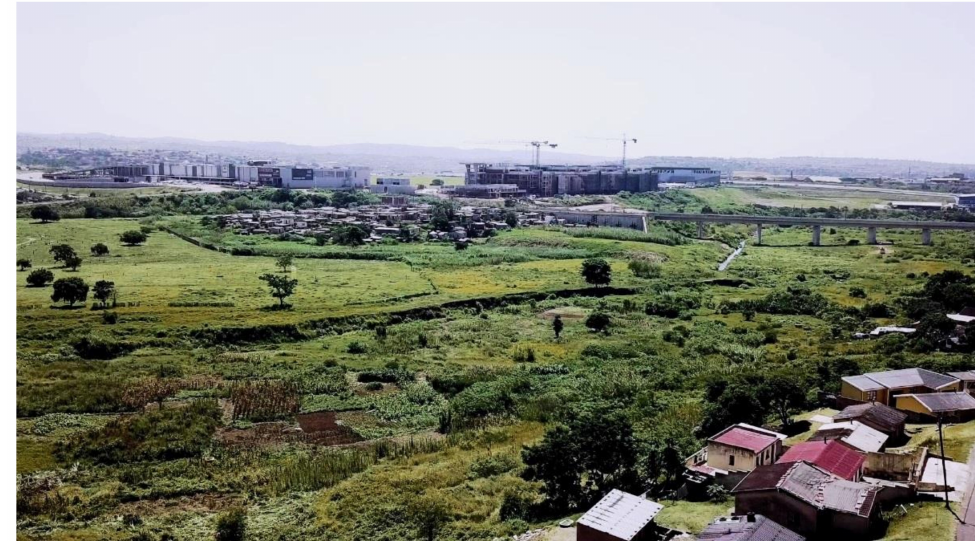
Figure 3. The Piesang’s River flood plain, viewed from KwaMashu towards Bridge City. Urban agriculture can be seen in the foreground, with the cemetery in the middle left. Source: GIZ, 2018. As in other sub-Saharan cities with urban expansion into flood-prone areas [3], the Piesang’s River valley is one of the largest of a few remaining patches of open space in the KwaMashu area. Nearly the entire valley falls within the 100-year flood line [66], which needs to be respected in any design solution for recreational use. A delineation and assessment of the wetland found the flood plain wetland system to be critically